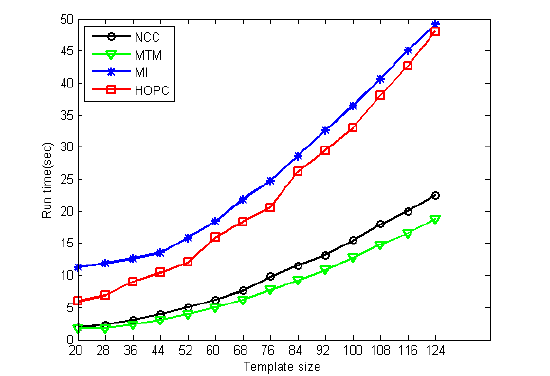
Figure 13. Run times of NCC, MTM, NCC and HOPC with increased template